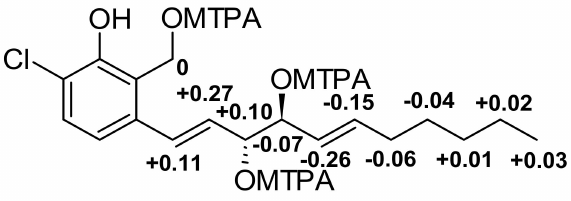
Figure 4. ∆ δ SR values for MPTA esters of 1 diagnostic for 10 R ,11 S . Compound 2 was obtained as a yellow oil. The molecular ion cluster at m/z 307.1276 [M + H] + in the HRESIMS spectrum indicated that the molecular formula of 2 was C 18 H 26 O 4